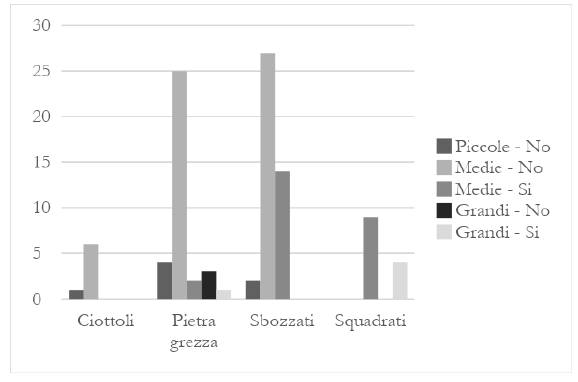
Figure 9. Relation between blocks shape, dimensions and regularity.